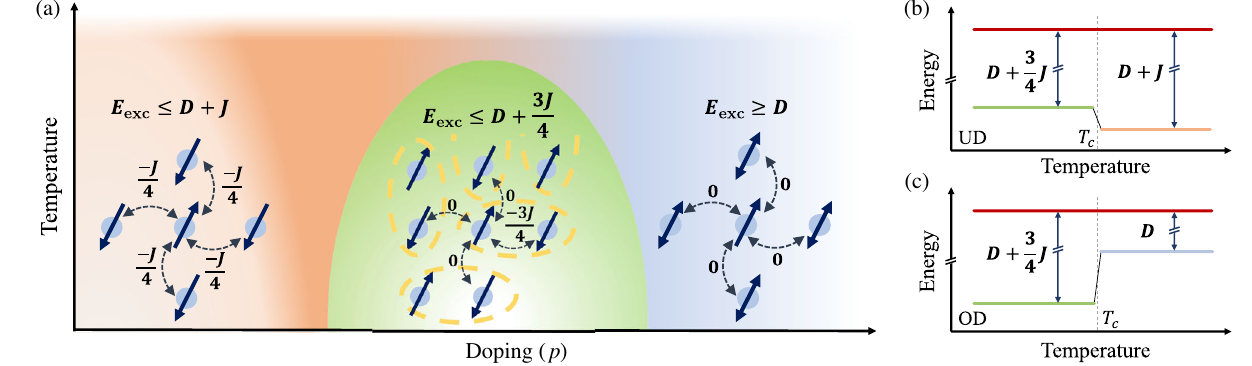
FIG. 6. (a) Phase diagram of the cuprates indicating the antiferromagnetic phase (beige), the normal phase (orange for underdoped and light blue for overdoped), and the superconducting phase (green) with the corresponding short-range spin correlations and dd exciton energies. (b),(c) Sketch of the temperature dependence of the dd exciton energy in the underdoped and overdoped